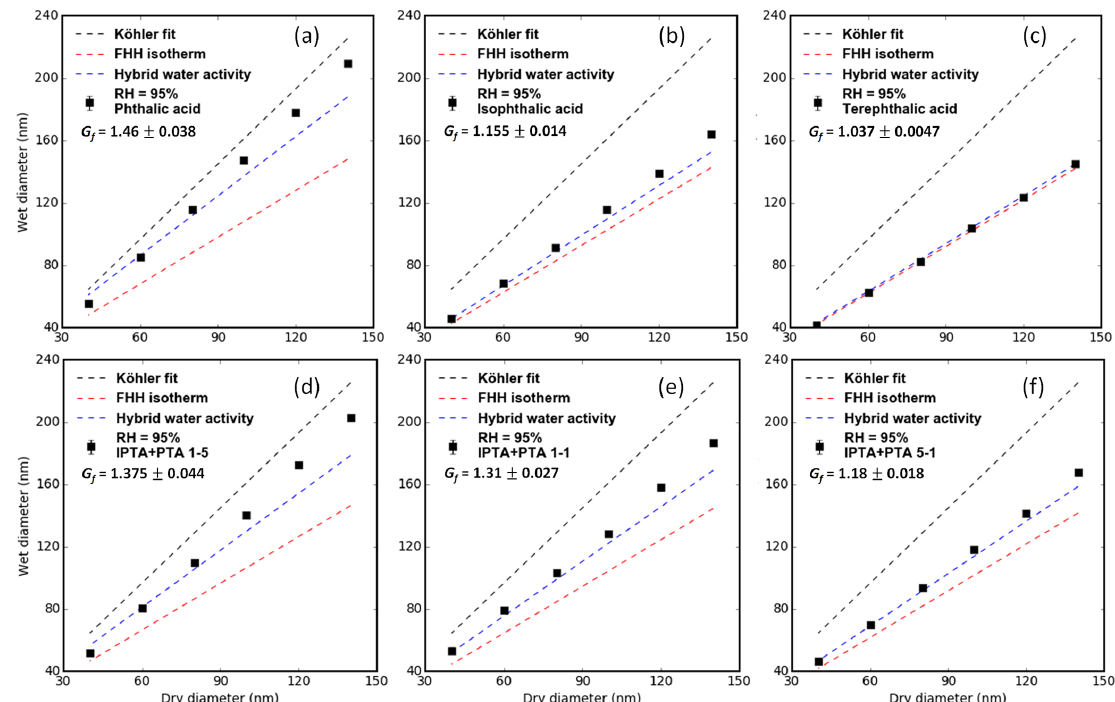
Figure 6. Subsaturated measurements for pure AAA samples obtained using the H-TDMA setup are shown. Panels (a) , (b) and (c) show the D wet vs. D dry data along with model fits for pure PTA, IPTA and TPTA. Panels (d) , (e) and (f) show the D wet vs. D dry data along with model fits for PTA–IPTA internal mixtures. The KT–Raoult term, FHH isotherm and hybrid water activity fits are shown in black, red and blue, respectively, overlaid with the experimental data. The hygroscopic growth factors ( G f ) for all AAA samples are shown in their